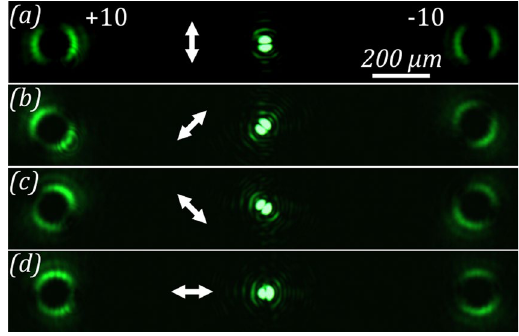
Figure 8. Diffraction pattern formed in the near-field region when passing the laser beam through the amplitude diffractive optical element, generating vortex beams with a topological charge m = ± 10 for different orientations of the analyzer. ( a ) 0, ( b ) + 45, ( c ) − 45, and ( d ) 90